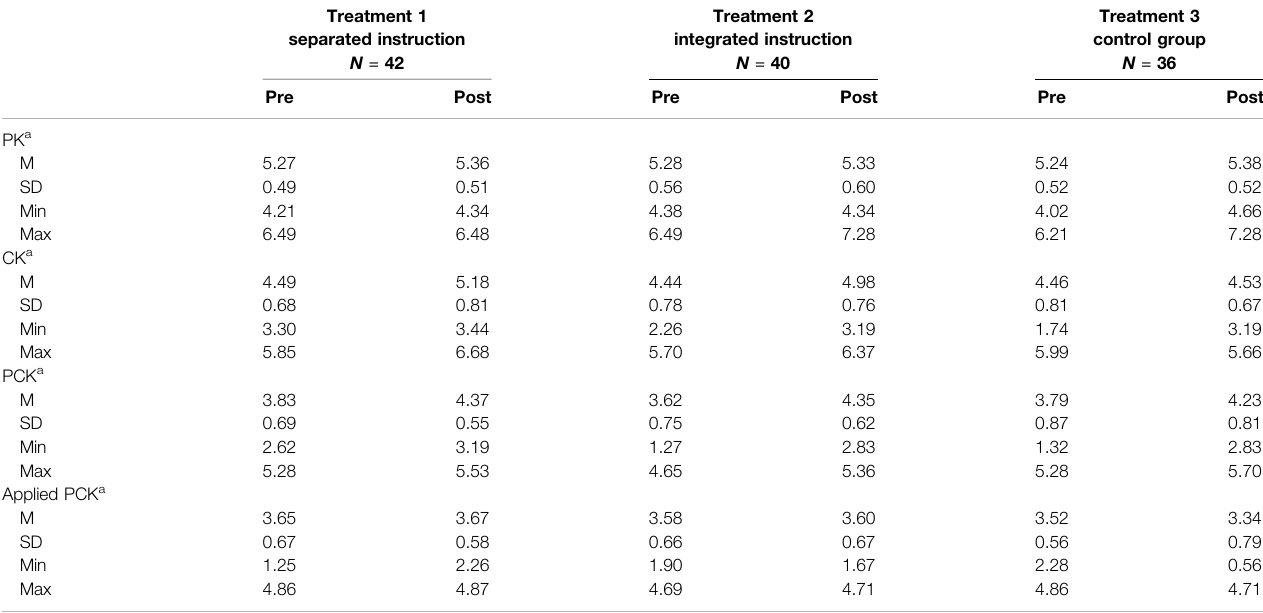
TABLE 6 | Descriptive statistics of the knowledge tests, including mean, standard deviation, minimum and maximum